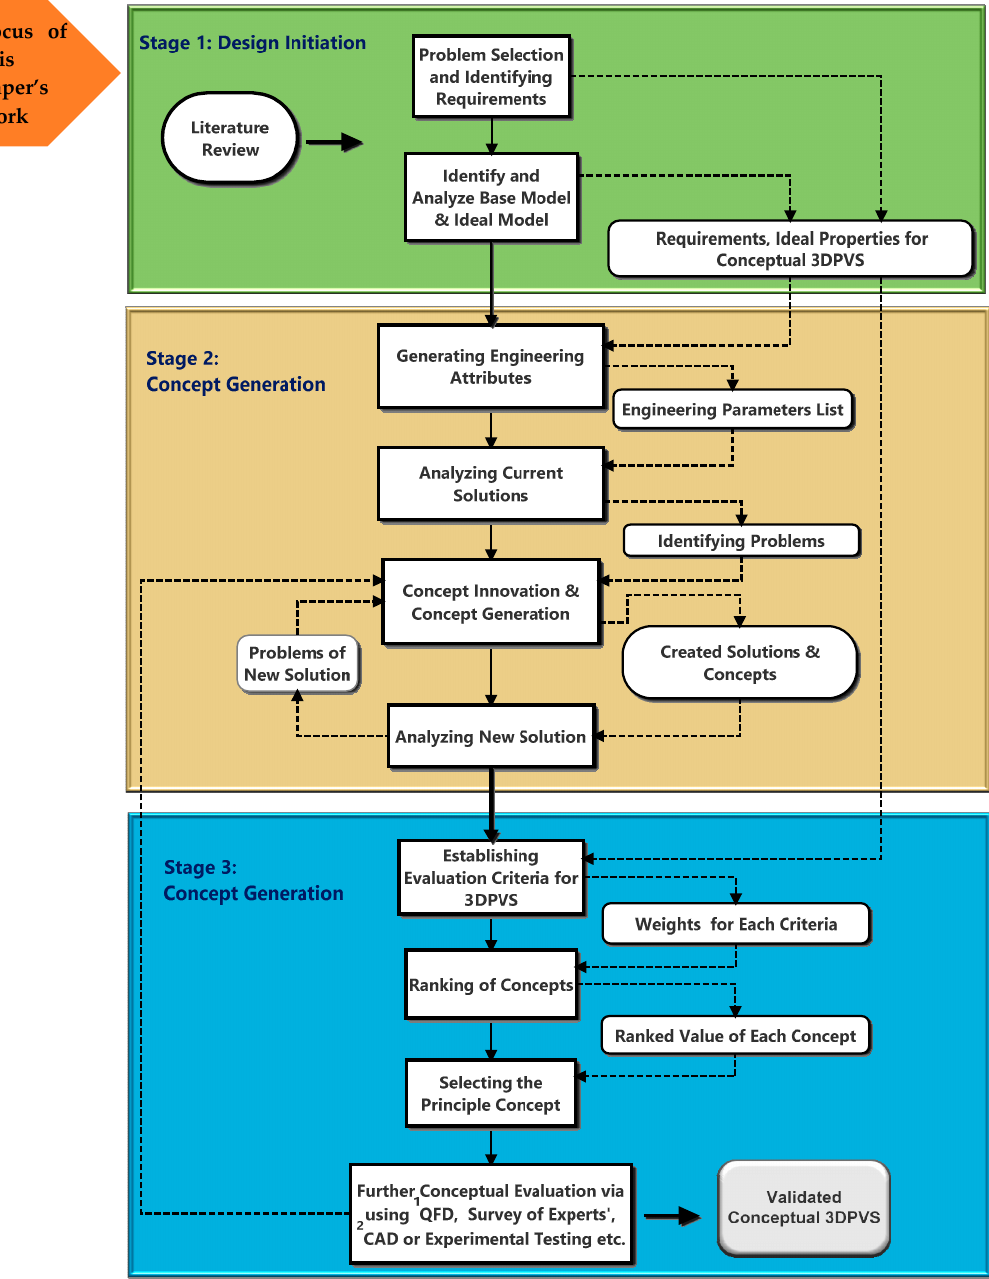
Figure 1. Illustration of the three-stage process for the development of the conceptual 3D printed vibratory scaffold (3DPVS). Note: 1 Quality Function Deployment, 2 Computer Aided Design.